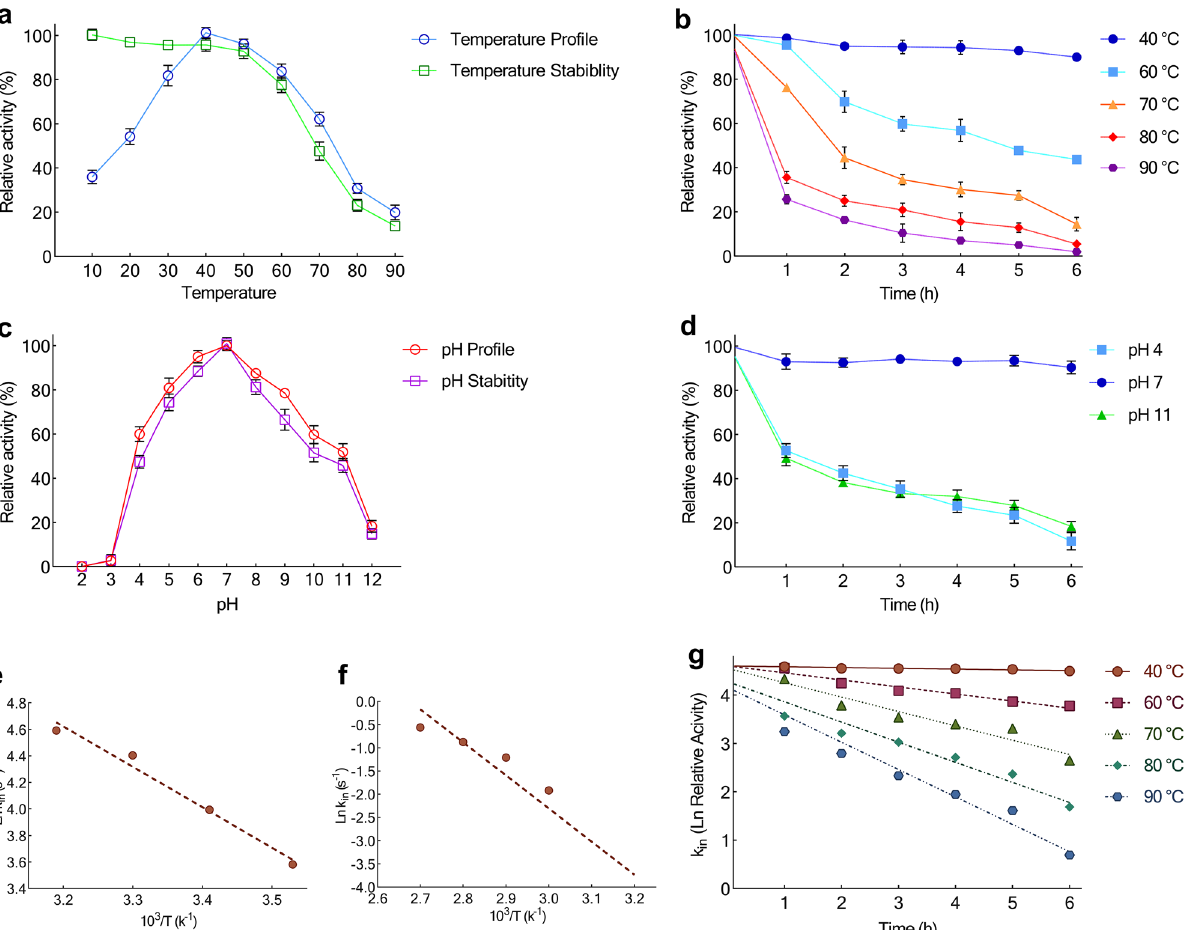
Figure 7. Effect of temperature and pH on the recombinant CelC307. Effect of temperature on the recombinant enzyme ( a ) activity and survival, and ( b ) stability. Effect of pH on the recombinant enzyme ( c ) activity and survival, and ( d ) stability. ( e ) Arrhenius plots for E a‡ . ( f ) Arrhenius plots for E a# . ( g ) Thermal inactivation Ln at 60, 70, 80, 90, and 100 °C. The graphs were plotted by using GraphPad Prism